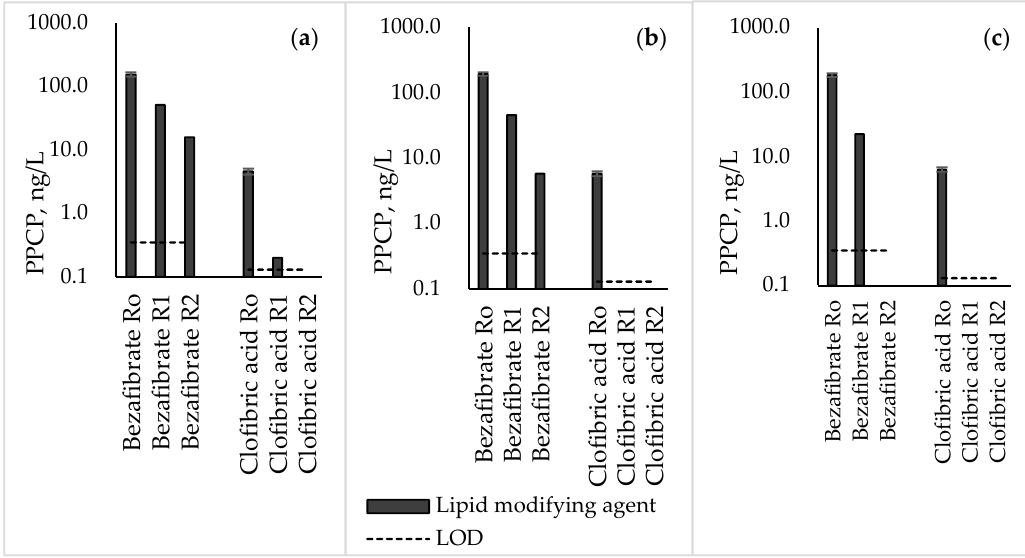
Figure 7. Concentrations of two lipid-modifying agents in the feed secondary effluent (R o ) and effluent of the R 1 and R 2 reactors at the O 3 doses of: ( a ) 1 and 2 mg L − 1 , respectively, in Run 1; ( b ) 2 and 4 mg L − 1 , respectively, in Run 2; and ( c ) 3 and 6 mg L − 1 , respectively, in Run 3.